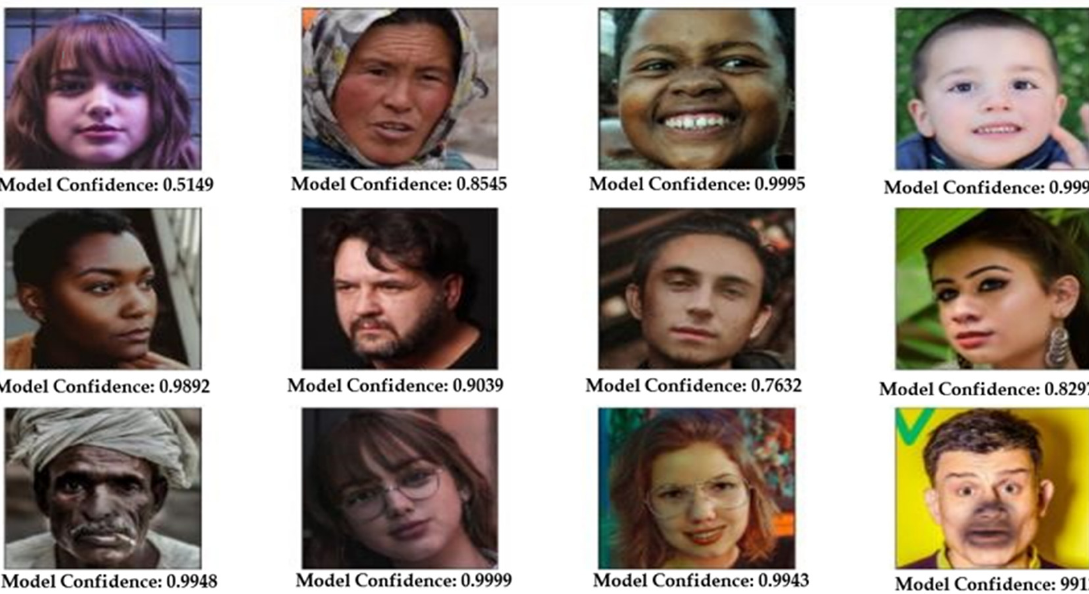
Figure 6. Correct real prediction: showing the model confidence in the prediction.